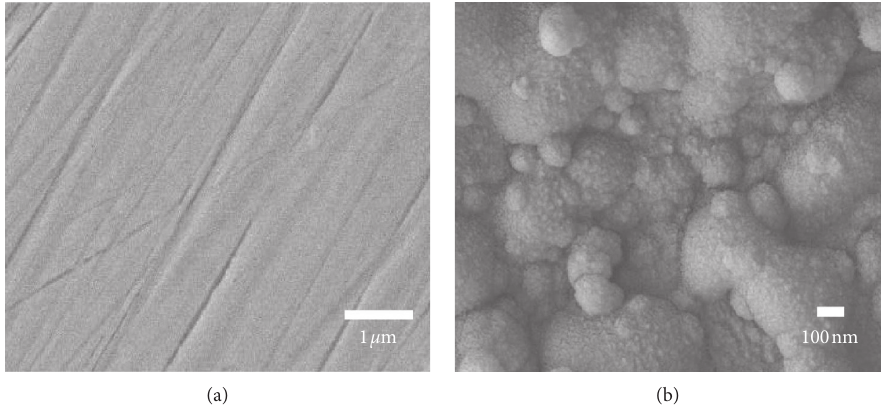
Figure 3: SEM images of the 316L electrode before (a) and after (b) modified with the PANI film.